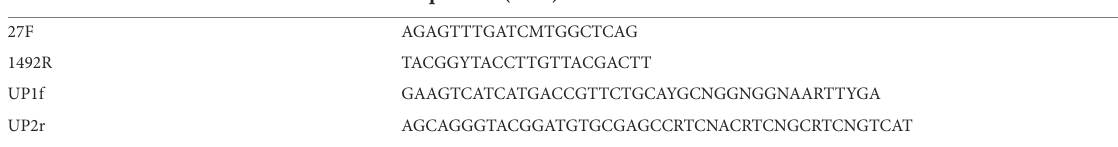
TABLE 3 Primers and sequences used for